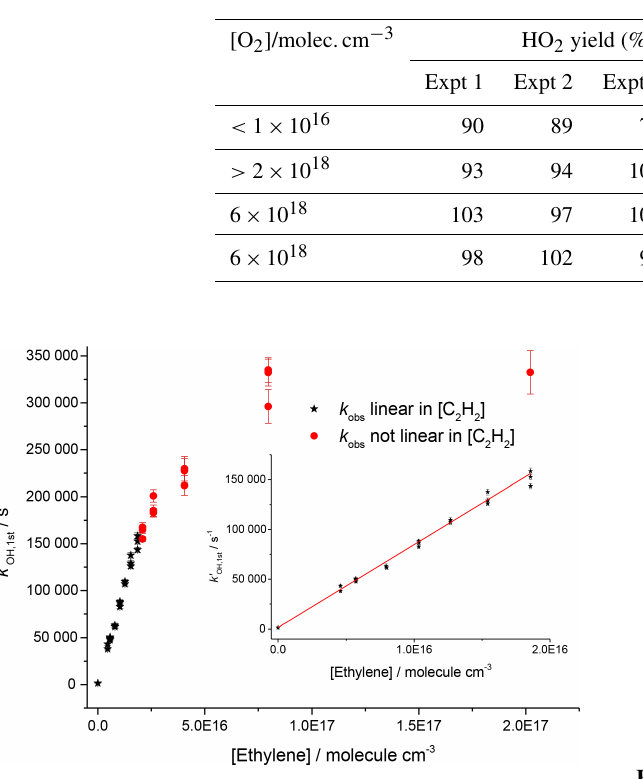
Figure 5. Bimolecular plot of the pseudo-1st-order rate coefficient at the first detector, k (cid:48) OH , 1st , vs. ethylene concentration. The fig- ure demonstrates a linear relationship below ∼ 150000s − 1 (see in- set for detail in linear region) but with increasing curvature due to transport effects at higher values of k (cid:48) OH , 1st . Black stars symbolize where k (cid:48) OH , 1st was linear with [C 2 H 4 ], and red circles show where k (cid:48) OH , 1st showed greater than 5% deviation from linearity.